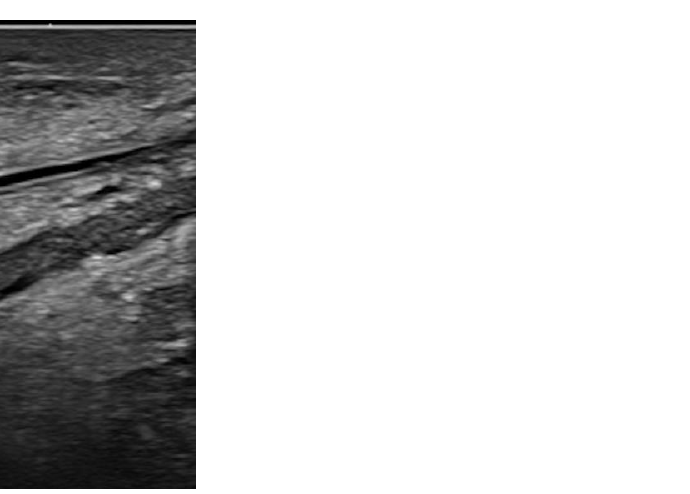
Figure 4. Breast ducts. The uppermost shows an anechoic content, while the other is filled with amorphous material.